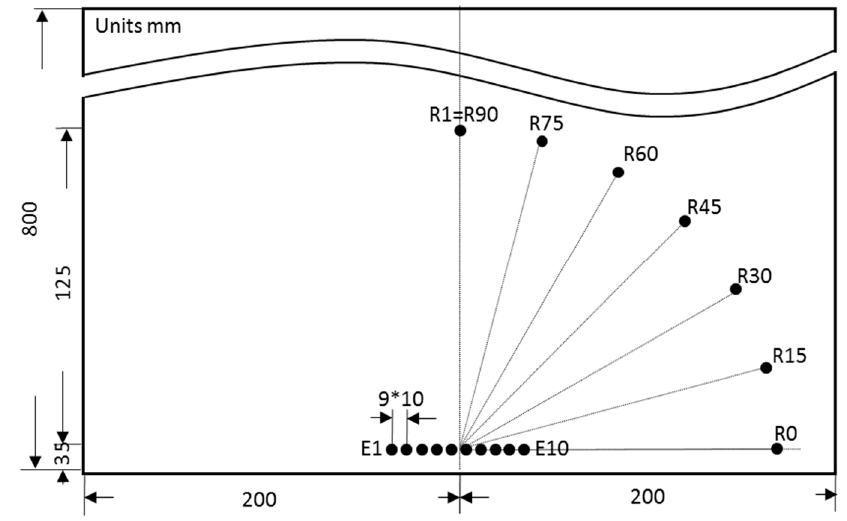
Figure 13. Arrangement of PWAS on the specimen to study wave spreading on different directions.